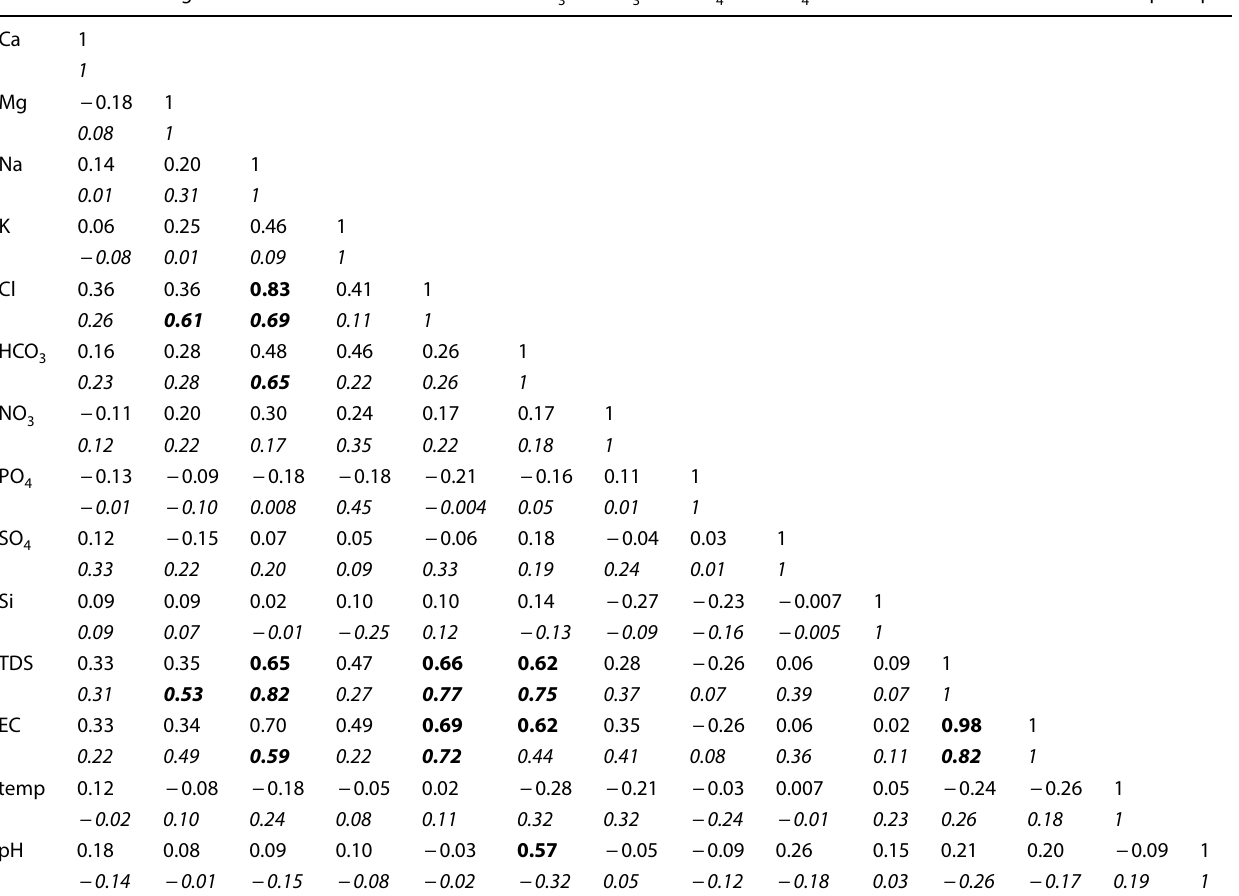
Table 5 Correlation analysis of groundwater samples for NEM and SWM (numbers in italics indicate the correlation coefficient of SWM sam- ples; numbers in bold indicates the good to significant positive